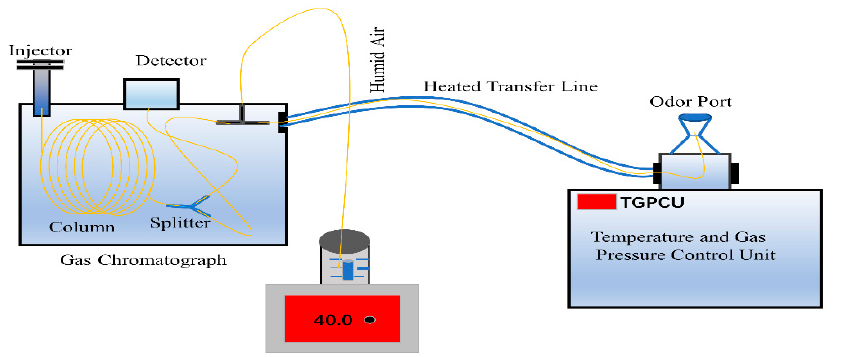
Figure 5. The schematic representation of gas chromatography-mass spectrometry coupled with olfactory detector.